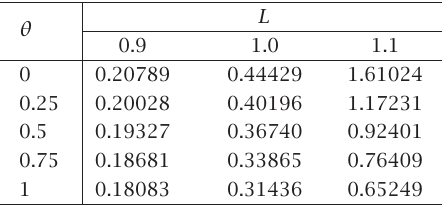
Table 4.3 . RAROC for bivariate portfolio